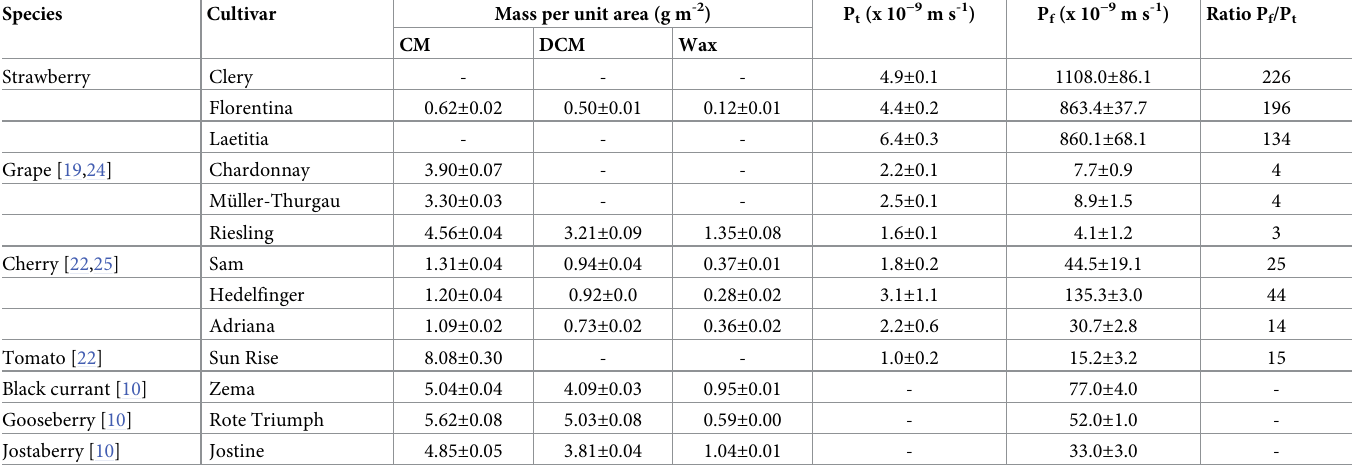
thinnest fruit cuticle ever reported (Table 1). There was no significant relationship between cuticle thickness and cuticle permeance. The extremely thin cuticle implies an extreme likeli- hood that surface defects will result if the fruit skin is subjected to high rates of strain during growth. The intracuticular waxes rather than the epicuticular waxes are considered to form the primary barrier to water movement across plant surfaces [36]. So, an extremely thin cuticle indicates an extreme dearth of intracuticular waxes and thus an extremely water-permeable skin. Moreover, our results reveal numerous cracks in the cuti- cle, particularly after the strawberry fruit skin has been in contact with surface water. Thus, an extremely thin cuticle along with a predisposition to microcracks indicates the barrier proper- ties of a strawberry fruit’s skin will be very limited in the dry and still further impaired by any exposure to surface wetness. Table 1. Mass of the cuticular membrane (CM), dewaxed CM (DCM) and permeances for transpiration (P t ) and for osmotic uptake (P f ) of a range of ripe fruitcrop species. Species